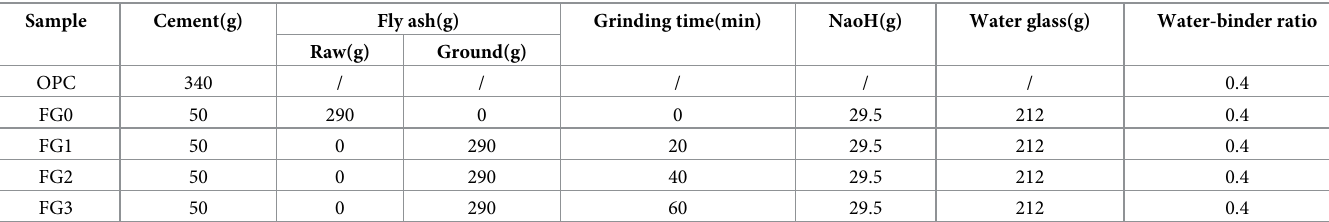
Table 2. Experimental design scheme.